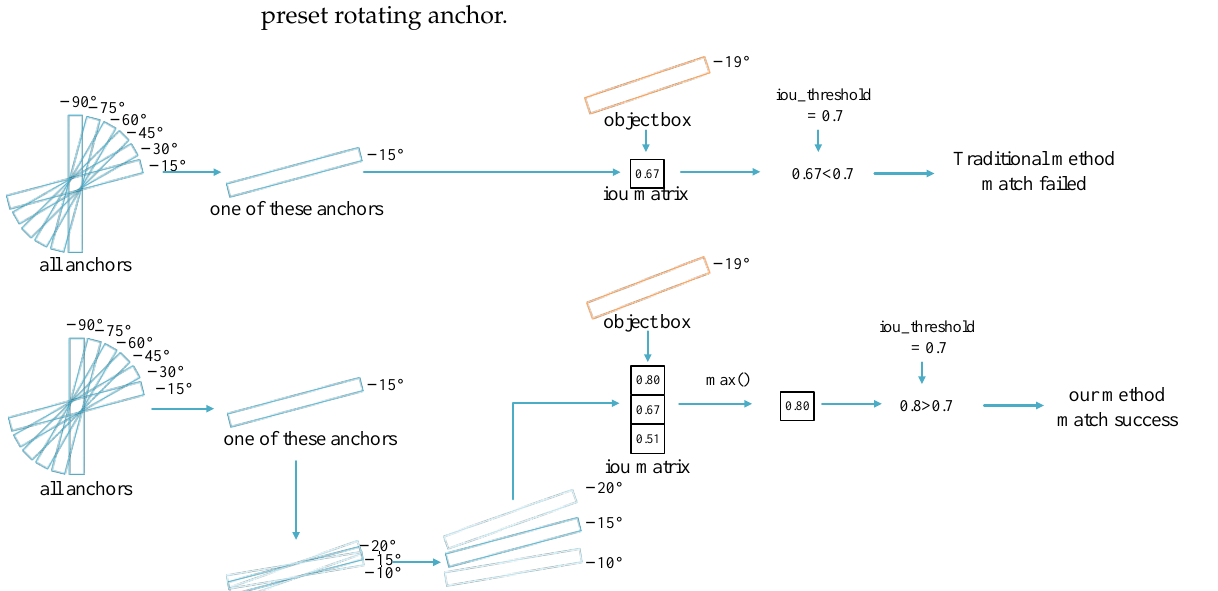
Figure 3. The schematic diagram of our method comparing the traditional matching method to this matching method. This figure shows a simplified process of matching an anchor with a target when the IoU threshold is 0.7. This method configures two auxiliary anchors for an anchor, calculates three IoUs with the target frame and then takes its maximum value.